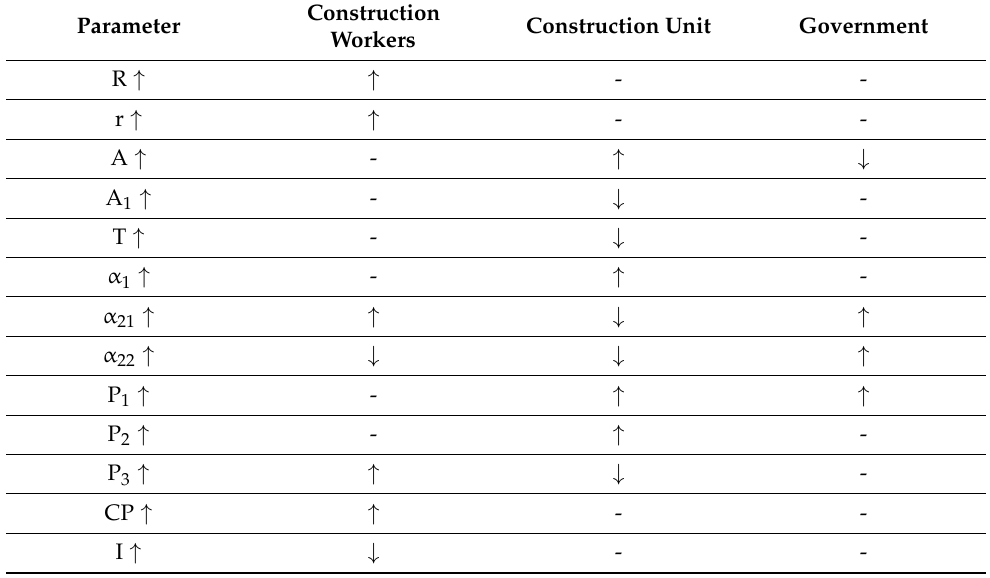
Table 7. Impacts of parameter